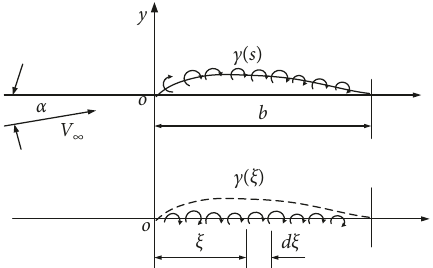
Figure 2: Circulation distribution along the